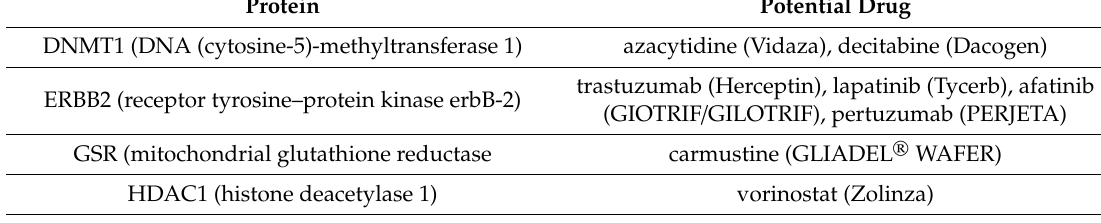
Table 5. List of protein targets and potential drugs in targeted therapies of OS, based on [173]. Protein Potential Drug DNMT1 (DNA (cytosine-5)-methyltransferase 1) azacytidine (Vidaza), decitabine (Dacogen) trastuzumab (Herceptin), lapatinib (Tycerb), afatinib ERBB2 (receptor tyrosine–protein kinase erbB-2) (GIOTRIF / GILOTRIF), pertuzumab (PERJETA) GSR (mitochondrial glutathione reductase carmustine (GLIADEL ®